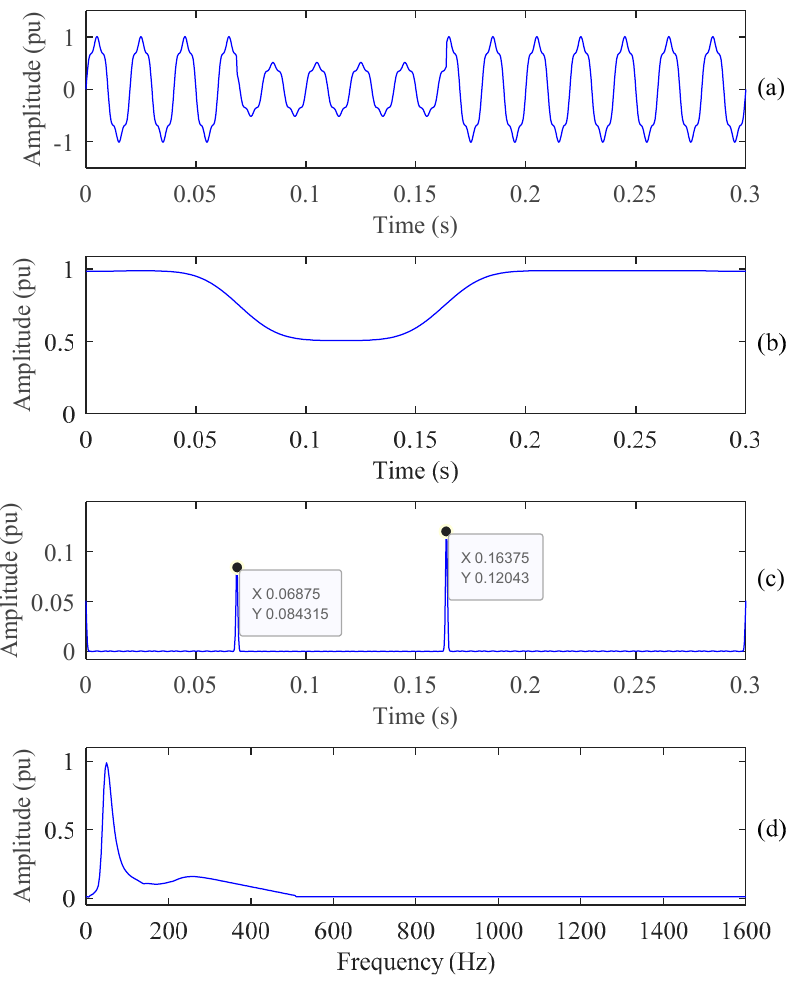
Figure 9. Harmonic voltage sag and related STA : ( a ) Voltage waveform; ( b ) TvA ; ( c ) TvHFA ; ( d ) FvA.